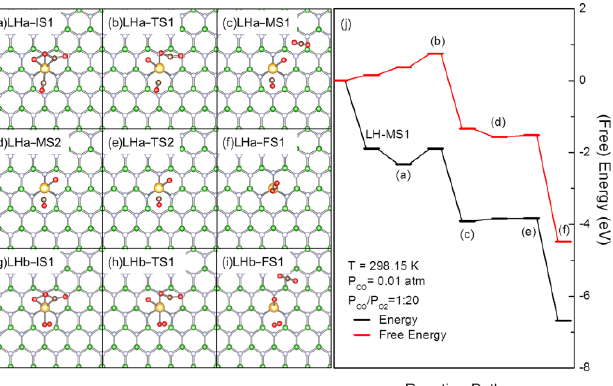
Figure 3. Optimized structures of the reaction species involved, including reaction intermediates, transition states and products ( a ) – ( i ), and (free) energy profiles ( j ) for CO oxidation over AuBN with the LHa and LHb pathways initiated with the coadsorption of CO or O 2 with LH-MS1. In ( a ) – ( i ), the B, N, C and Au atoms are in green, light blue, brown and gold, respectively. In ( j ), the bracketed letters correspond to the structures shown in ( a ) – ( i ).